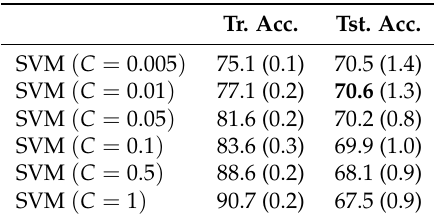
Table 6. Average results obtained by Support Vector Machines (SVMs). Each row illustrates the accuracy results with respect to the C parameter.